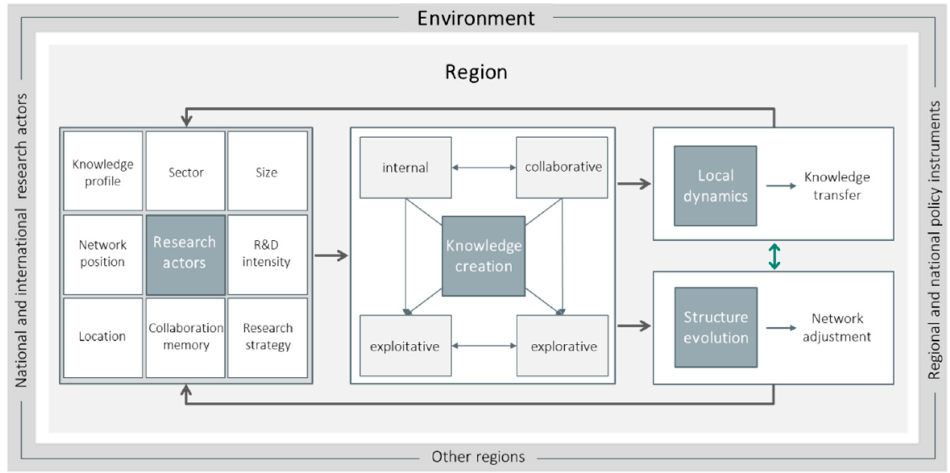
Figure 1. Overview of model elements and processes—region perspective.